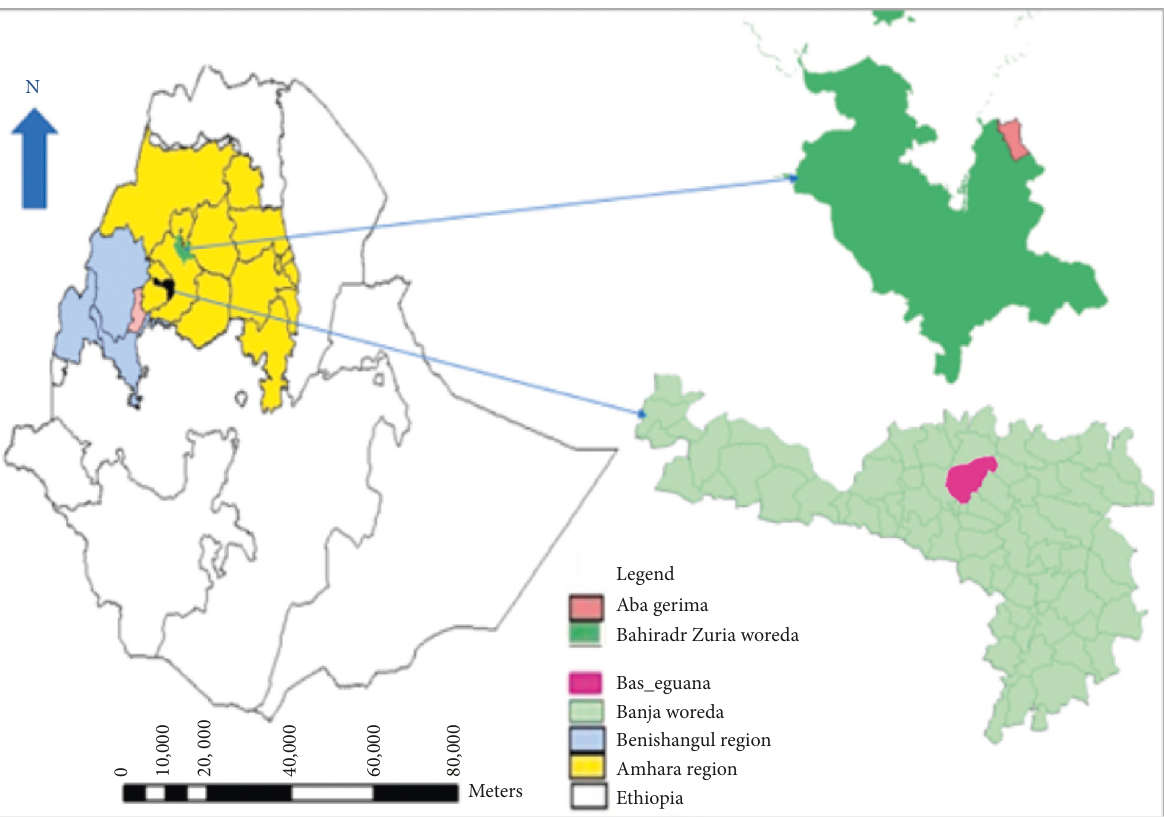
Figure 1: Map of study